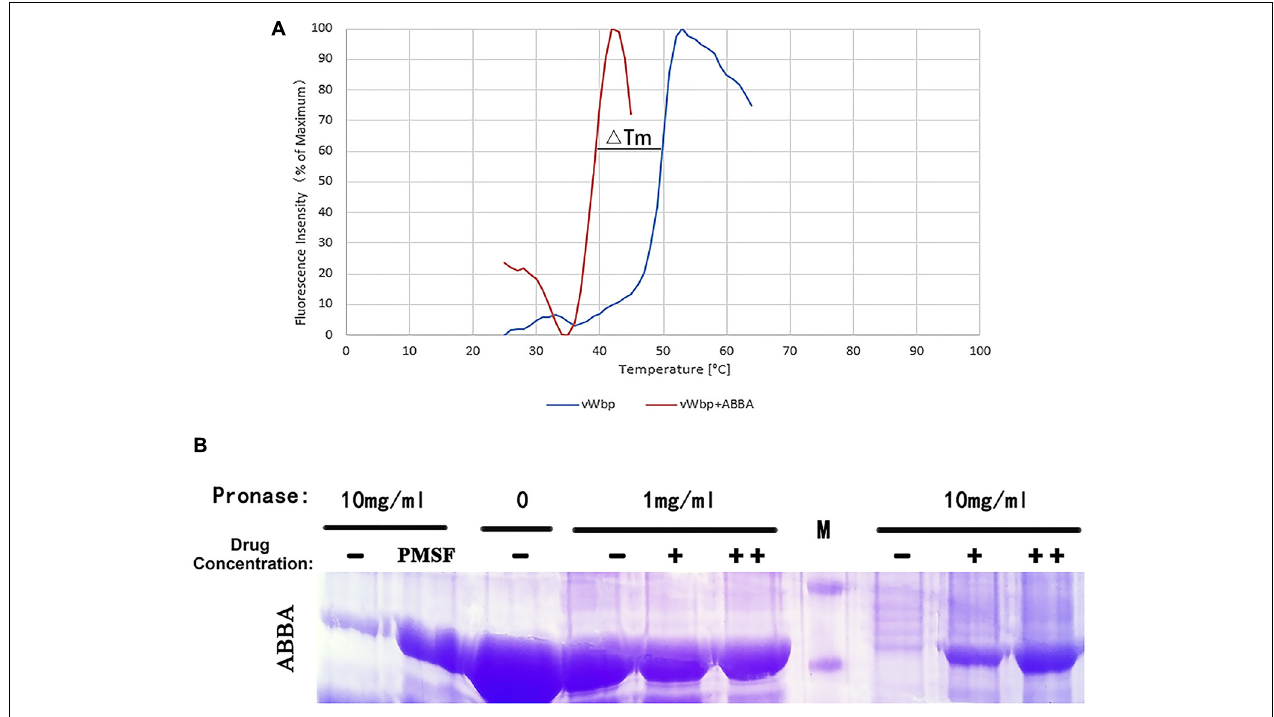
FIGURE 4 | Fluorescence-based thermal shift assay results and representative DARTS results for pronase E-digested vWbp. (A) To identify whether ABBA can improve the thermal stability of vWbp, vWbp was subjected to a thermal shift assay in the presence of 64 µ g/ml ABBA (red curves) or buffer only (blue curves). (B) SDS-PAGE bands from left to right: 1, negative control, vWbp + 10 mg/ml pronase E; 2, positive control, vWbp +10 mg/ml pronase E + PMSF (inhibitor of pronase E); 3, vWbp; 4, vWbp + 1 mg/ml pronase E; 5, vWbp + 1 mg/ml pronase E + 64 µ g/ml ABBA; 6, vWbp + 1 mg/ml pronase E + 128 µ g/ml ABBA; 7, marker; 8, vWbp + 10 mg/ml pronase E; 9, vWbp + 10 mg/ml pronase E + 64 µ g/ml ABBA; 10, vWbp + 10 mg/ml pronase E + 128 µ g/ml ABBA.